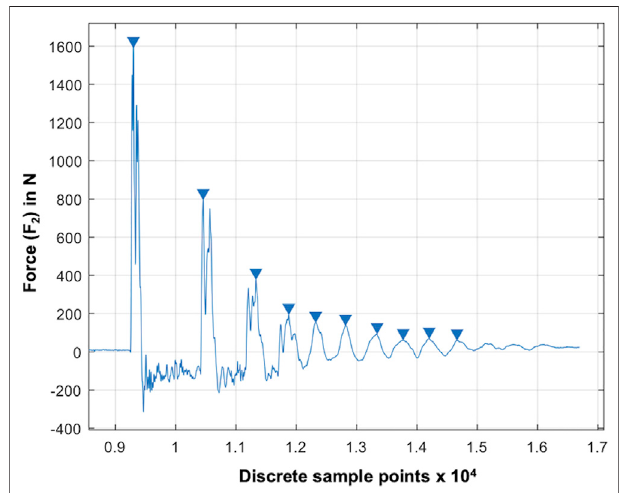
FIGURE 3 | Result graph of a droptower validation test using a known damping material (RF220). The blue arrows indicate automatically determinedlocalmaxima(x n :bluearrows) atthelowerforcesensor(F 2 ).The force is given over the discrete sample points at a sampling rate of 20